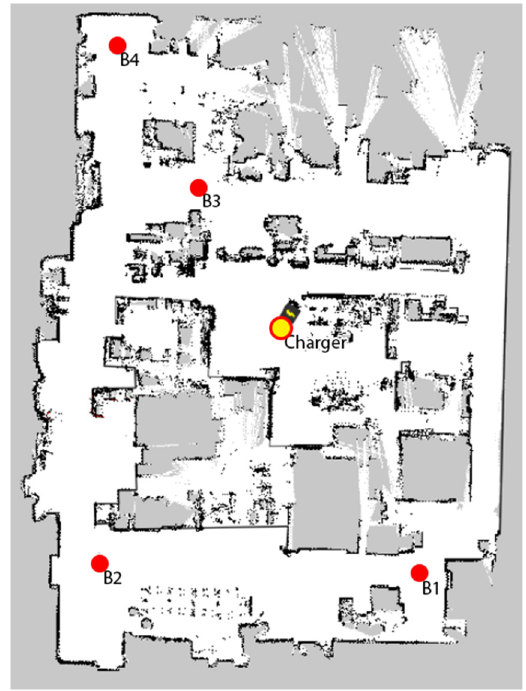
Figure 3. Map of the robot’s working area.